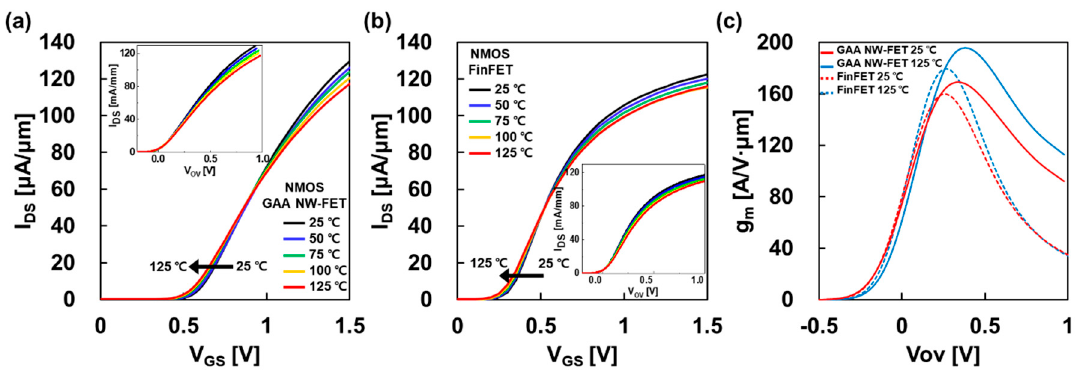
Figure 3. Measured I DS -V GS curves (linear region, V DS = 50 mV) under various temperature conditions from 25 to 125 ◦ C for ( a ) GAA NW-FET. ( b ) FinFET with L G = 30 nm. Insets: I DS -V OV ( V OV = V GS − V TH ) curves. ( c ) g m -V GS curves for GAA NW-FET and FinFET for 25 and 125 ◦ C.